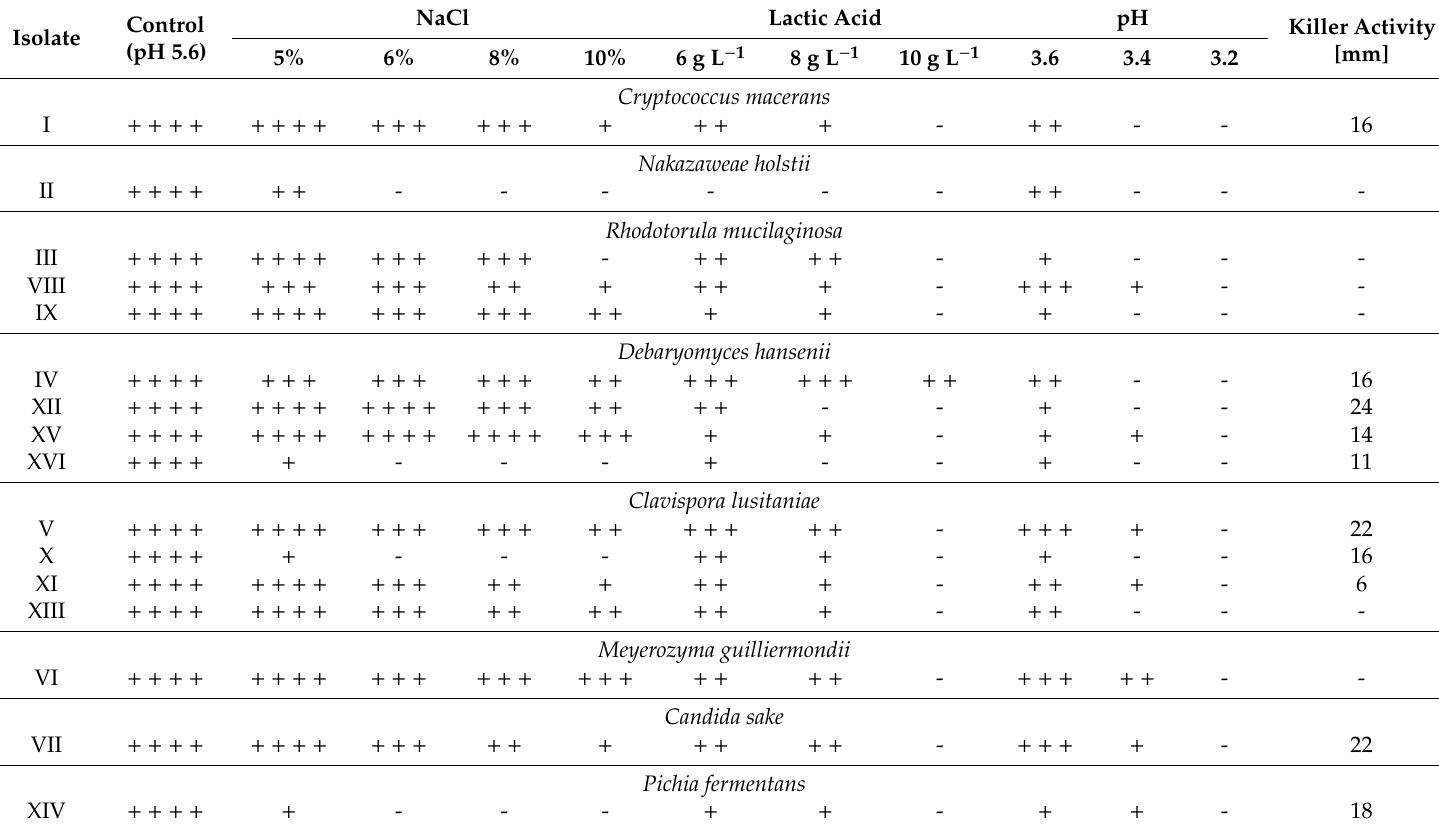
Table 2. Growth of sauerkraut isolates on substrates containing di ff erent concentrations of NaCl, lactic acid or di ff erent pH and their killer activity.